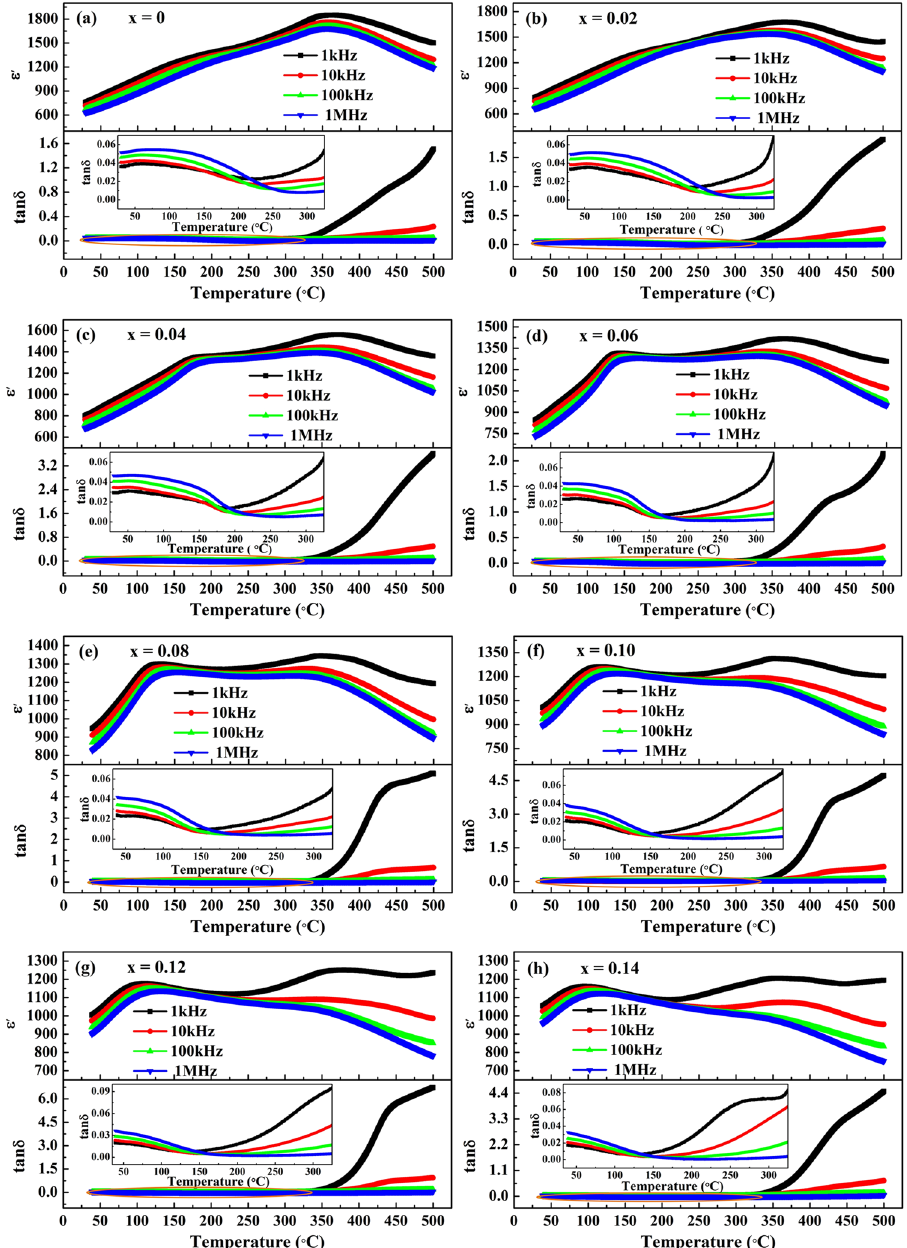
Figure 3. Temperature dependence of dielectric constant and dielectric loss of the (1-x)LLBNTZ-xNBN ceramics measured from 1 kHz to 1 MHz: ( a ) x = 0, ( b ) x = 0.02, ( c ) x = 0.04, ( d ) x = 0.06, ( e ) x = 0.08, ( f ) x = 0.10, ( g ) x = 0.12, ( h ) x = 0.14. (The inset shows dielectric loss of the (1-x)LLBNTZ-xNBN ceramics from room temperature to 325